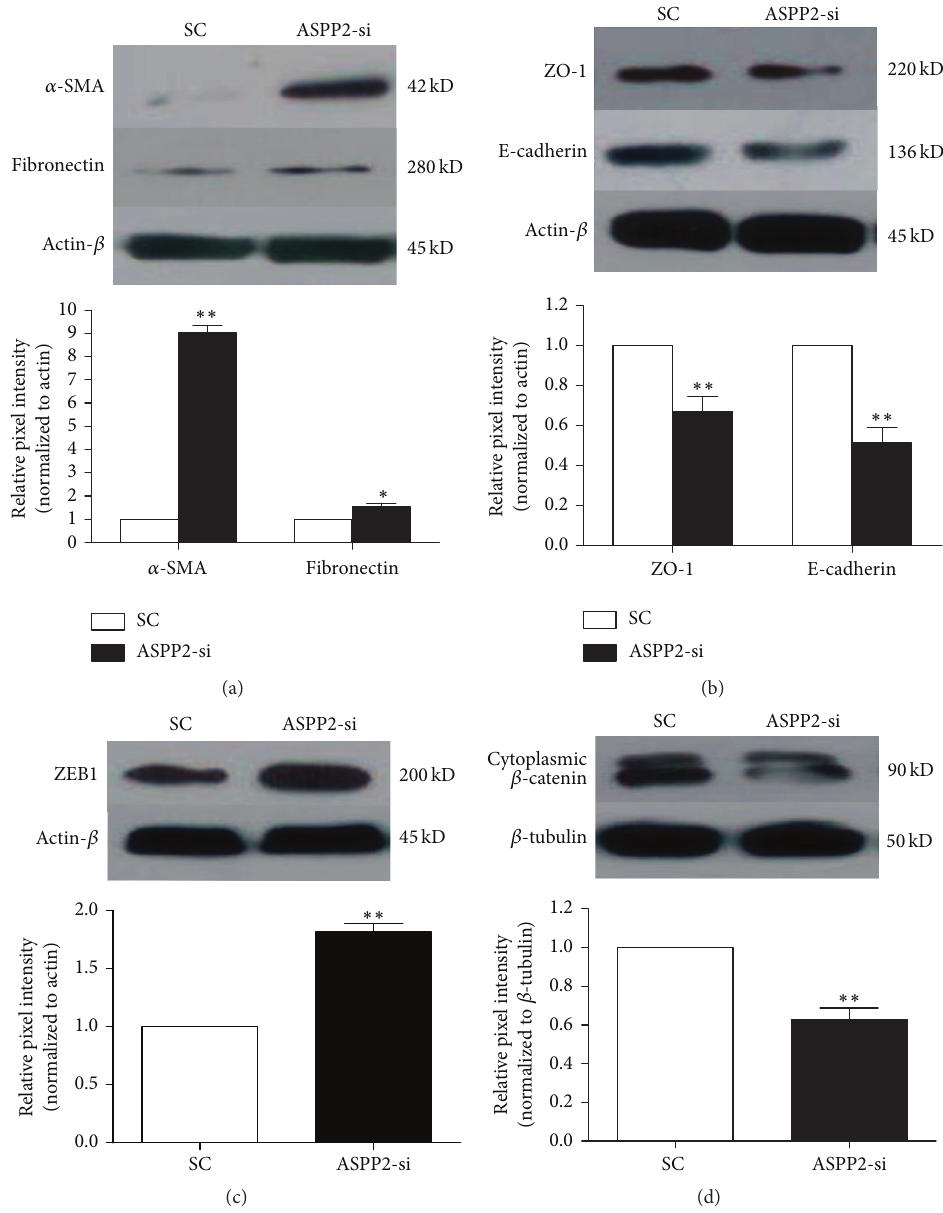
Figure 4: Effects of ASPP2 on the protein expression of epithelial and mesenchymal markers of ARPE-19 cells. Western blot images of expression of epithelial markers (ZO-1, E-cadherin, and 𝛽 -catenin) were significantly decreased, while mesenchymal markers ( 𝛼 -SMA, fibronectin, and ZEB1) significantly increased in ARPE-19 cells 48h after ASPP2-siRNA transfection, when compared to the scrambled control-siRNA transfection (a, b, c, and d). 𝛽 -actin or 𝛽 -tubulin was used as a loading control. Representative results obtained in three independent experiments are shown. Column diagrams and bars represent the ratio of the scanned immunoblots of mesenchymal markers and epithelial markers to 𝛽 -actin or 𝛽 -tubulin. Data are shown as the mean ± SD, 𝑛 = 3 experiments. ∗ 𝑃 < 0.05 versus SC group; ∗∗ 𝑃 < 0.01 versus the SC group. SC was set to 100%. SC, scrambled control-siRNA-transfected cells; ASPP2-si, ASPP2-siRNA-transfected